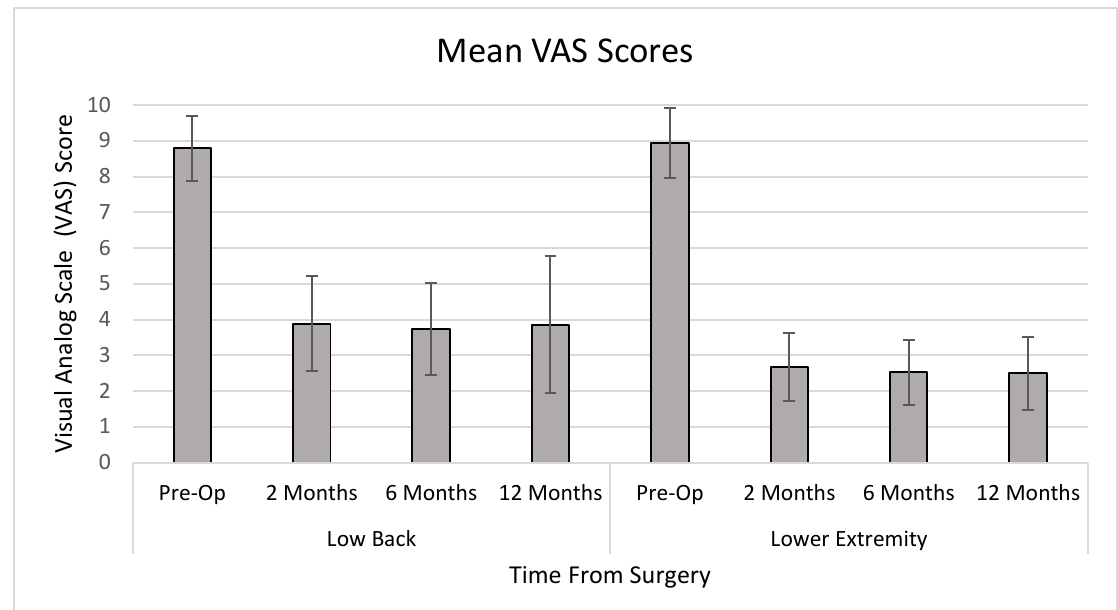
Figure 1. Mean VAS scores for low back pain and lower extremity pain over time .